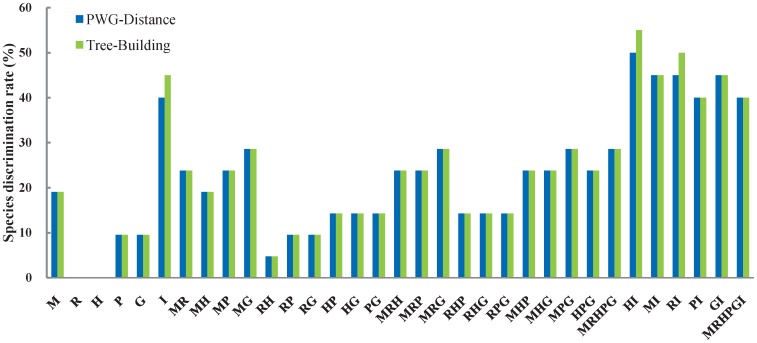
Species discrimination rate of all tested single- and multi- locus barcodes in Populus.M, matK; R, rbcL; H, trnH-psbA; P, psbK-psbI; G, trnG-psbK; I, ITS; NJ, Neighbor-Joining.